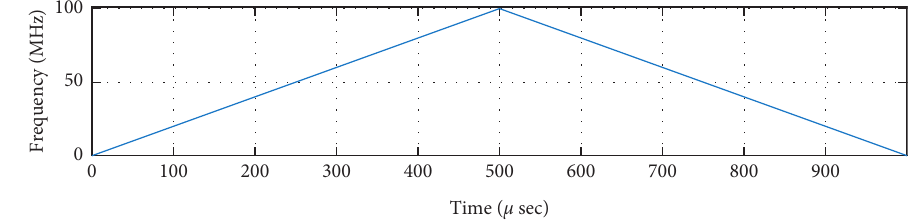
Figure 21: One period of a FMCW waveform.